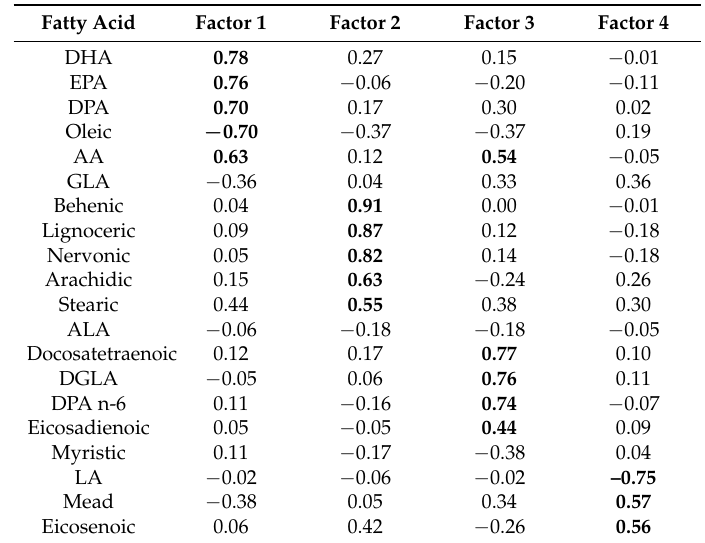
Table 5. Factor analysis of fatty